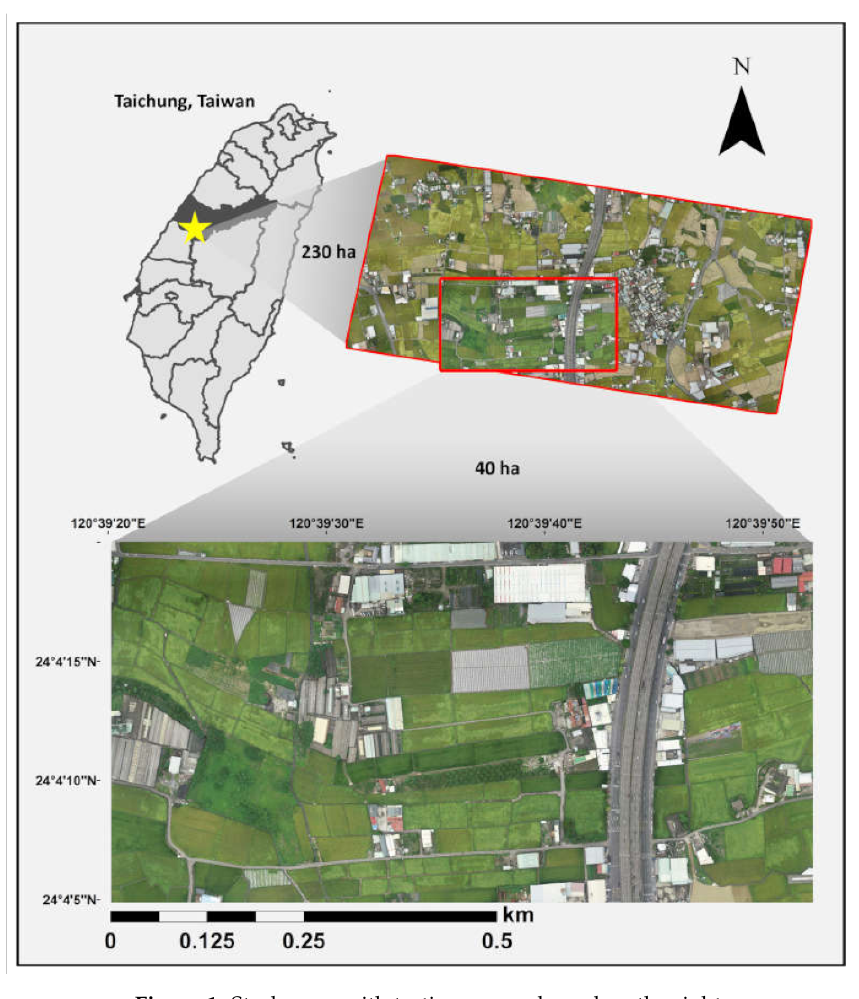
Figure 1. Study area with testing area enlarged on the right.